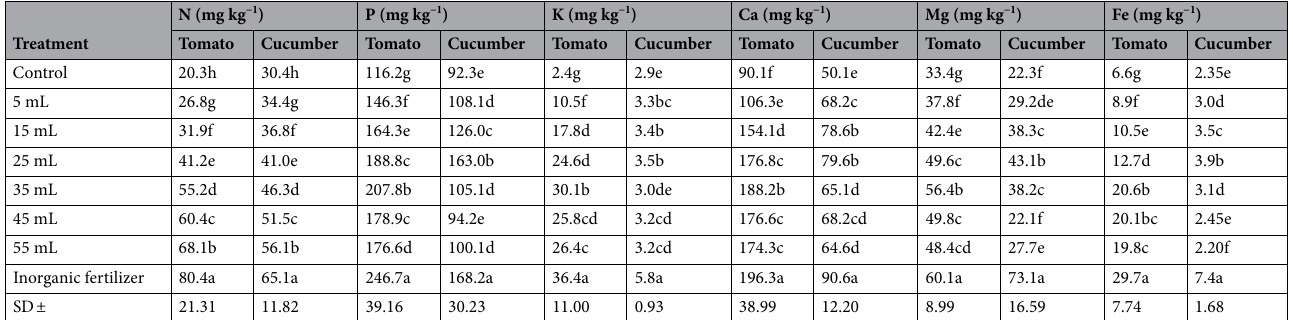
Table 3. Effect of organic and in-organic fertilizers of on mineral contents of tomato and cucumber fruits under soilless medium (means from sites A & B). Values followed by similar letters under the same column are not significantly different at p = 0.05 according to Duncan’s multiple range